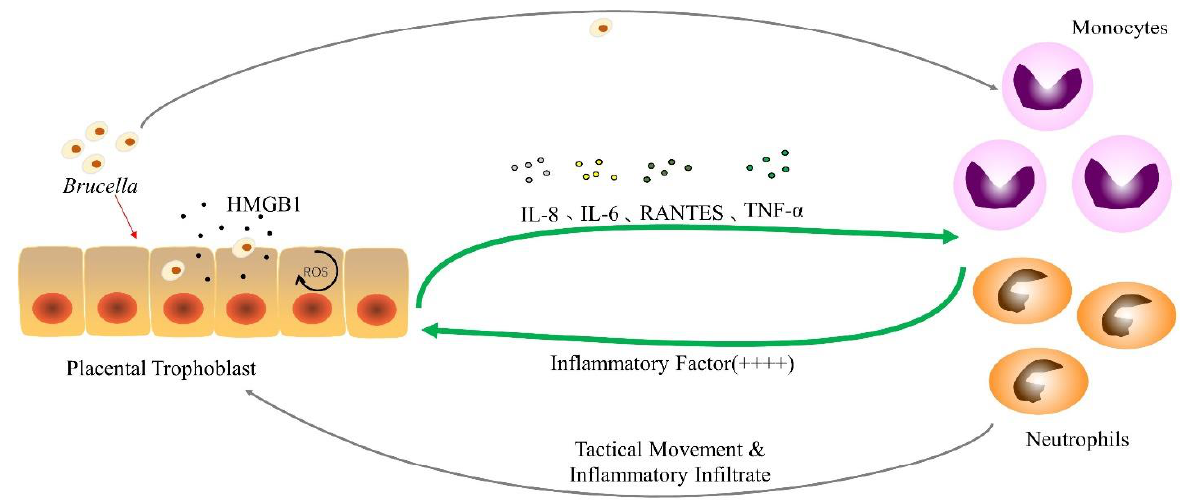
Figure 3. The interaction between Brucella and phagocytic cells after infection of trophoblast cells. After the trophoblast cells are attacked by Brucella , they begin to produce HMGB1 and excrete HMGB1, increasing the concentration of ROS in response to changes in the intracellular environment and secrete cytokines such as IL-6, IL-8, RANTES and TNF- α . Monocytes and neutrophils move to the placental infection site and secrete a large number of inflammatory factors after receiving the stimulation of Brucella and cytokines, causing placental inflammatory infiltration.“++++” indicates an increase in the degree of inflammatory response, which is a positive feedback of inflammatory cells to trophoblast cell signals. The specific inflammatory secreted factors are shown in Table 1.